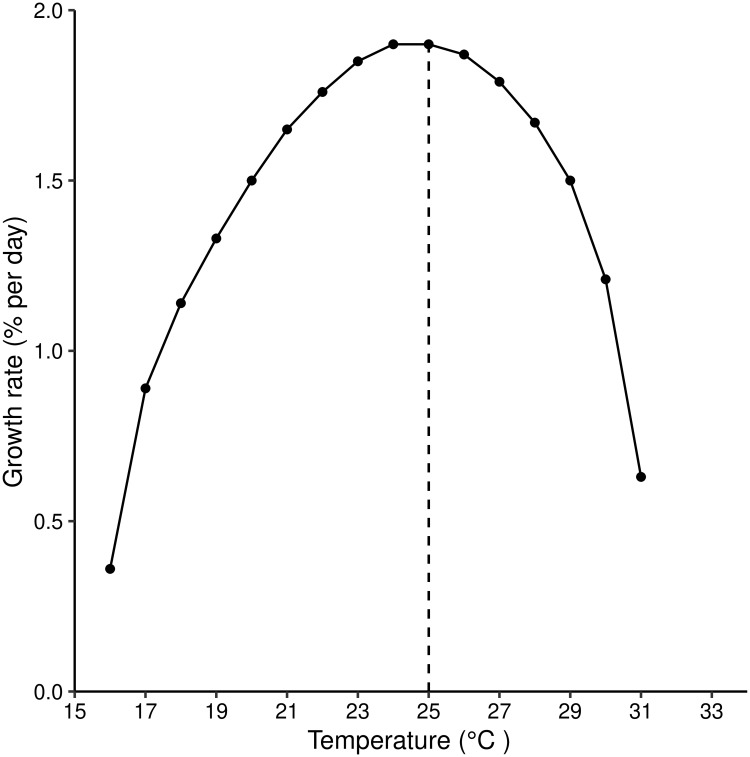
Daily growth rate (%) of a population of G. m. morsitans living at different constant temperatures (15°C–35°C).The vertical dotted line at 25°C indicates the temperature at which the growth rate is maximised.